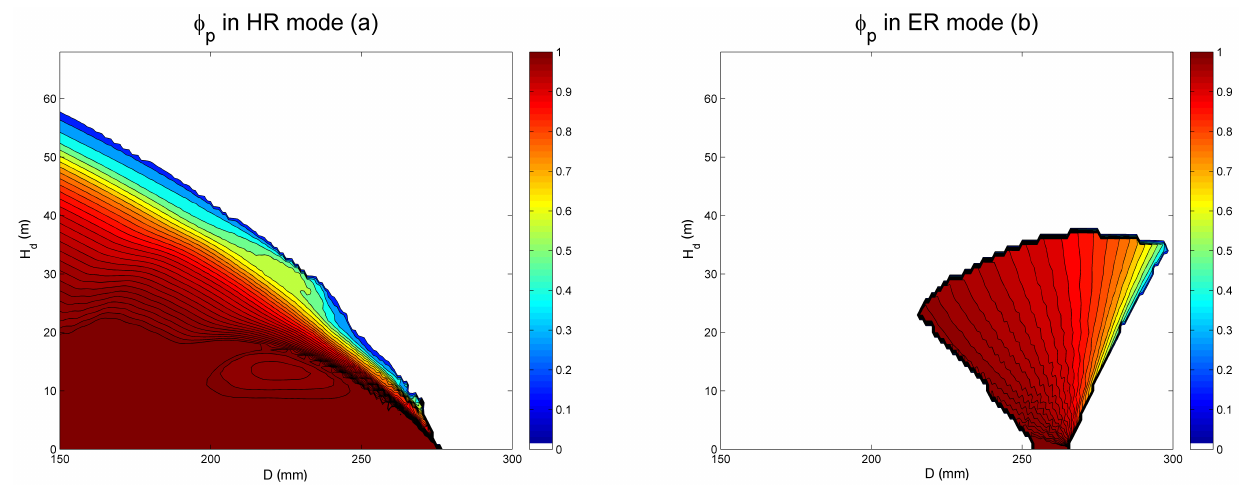
Figure 4. φ values resulting from VOS: ( a ) HR mode; and ( b ) ER p